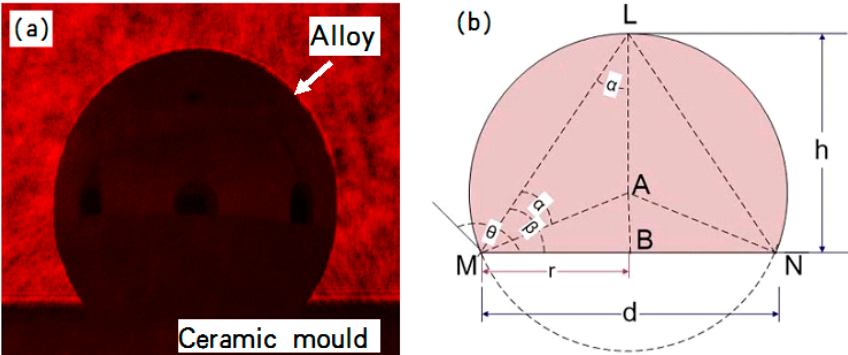
Figure 3. Images of ( a ) the alloy drop on the ceramic and ( b ) the schematic illustration of the measurement of h and d .